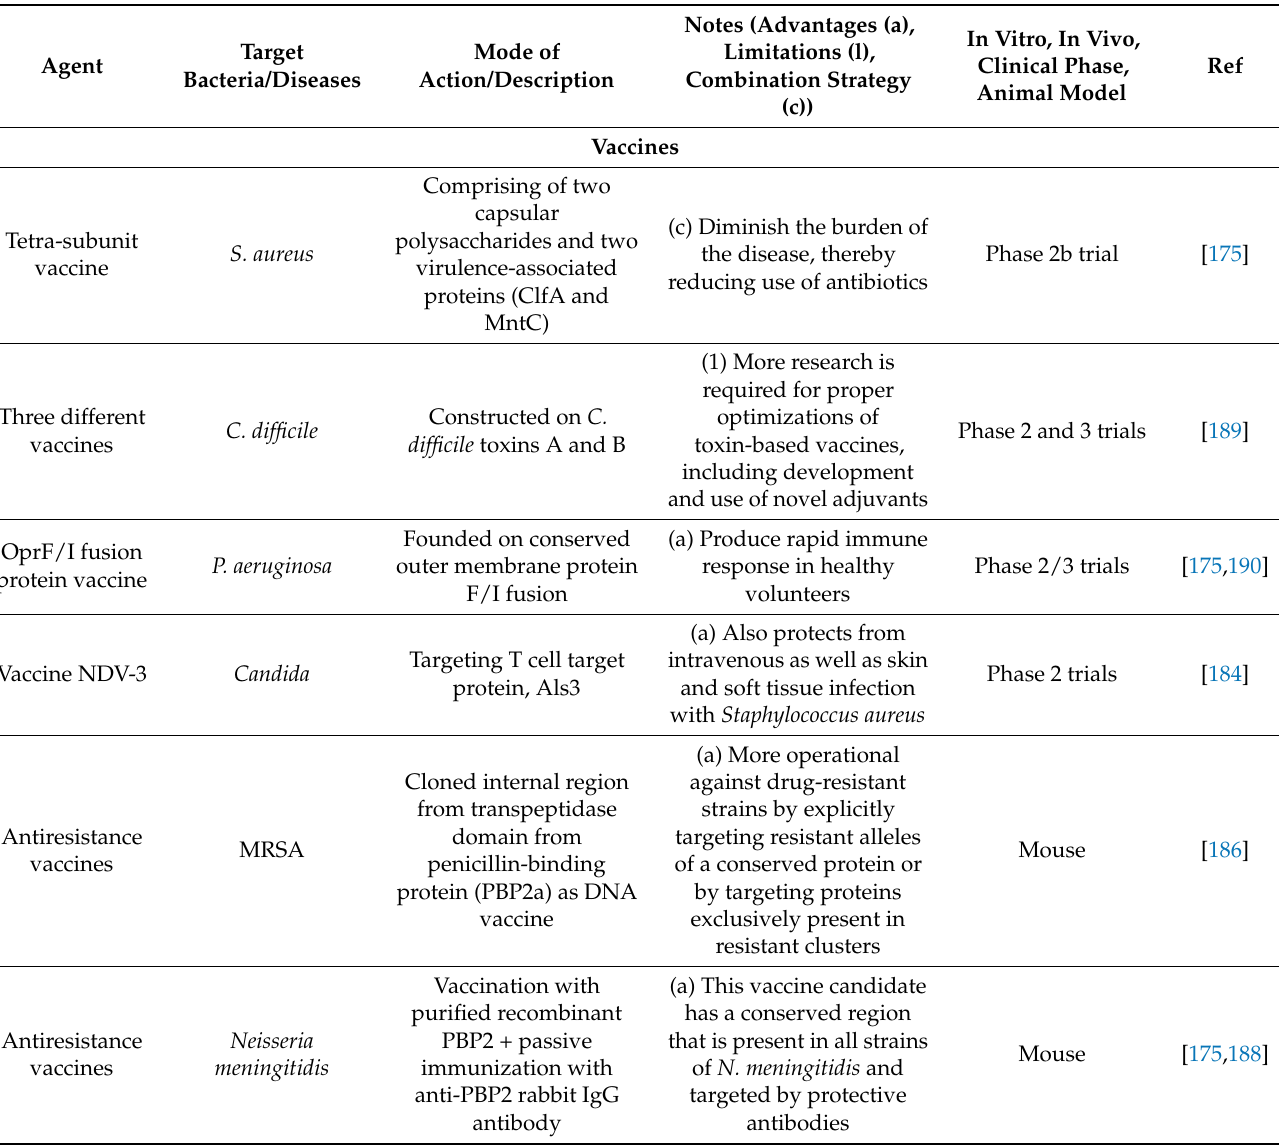
Table 5. Different types of vaccines used to fight the bacterial multidrug